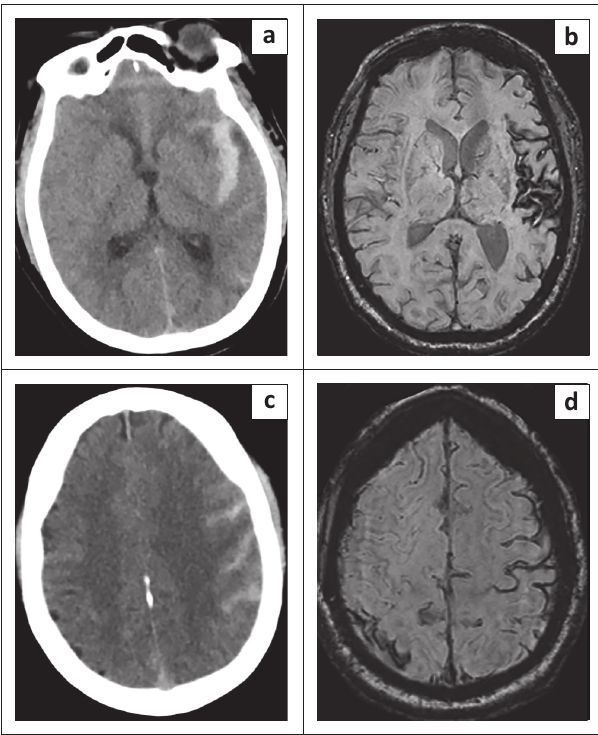
FIGURE 6: The NECT (a, c) and SWI (b, d) in ruptured left MCA aneurysm. Subarachnoid haemorrhage in the left Sylvian cistern (a) and left frontoparietal convexities (c) and SWI at 3 months demonstrates corresponding blooming in the respective zones (b, d). Of note the maximum haemorrhage load and haemosiderin zone localises to the left Sylvian